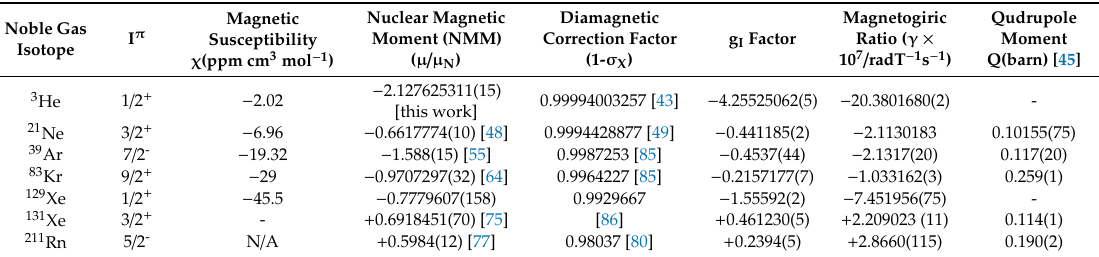
Table 8. Preferred values of electromagnetic properties of noble gas